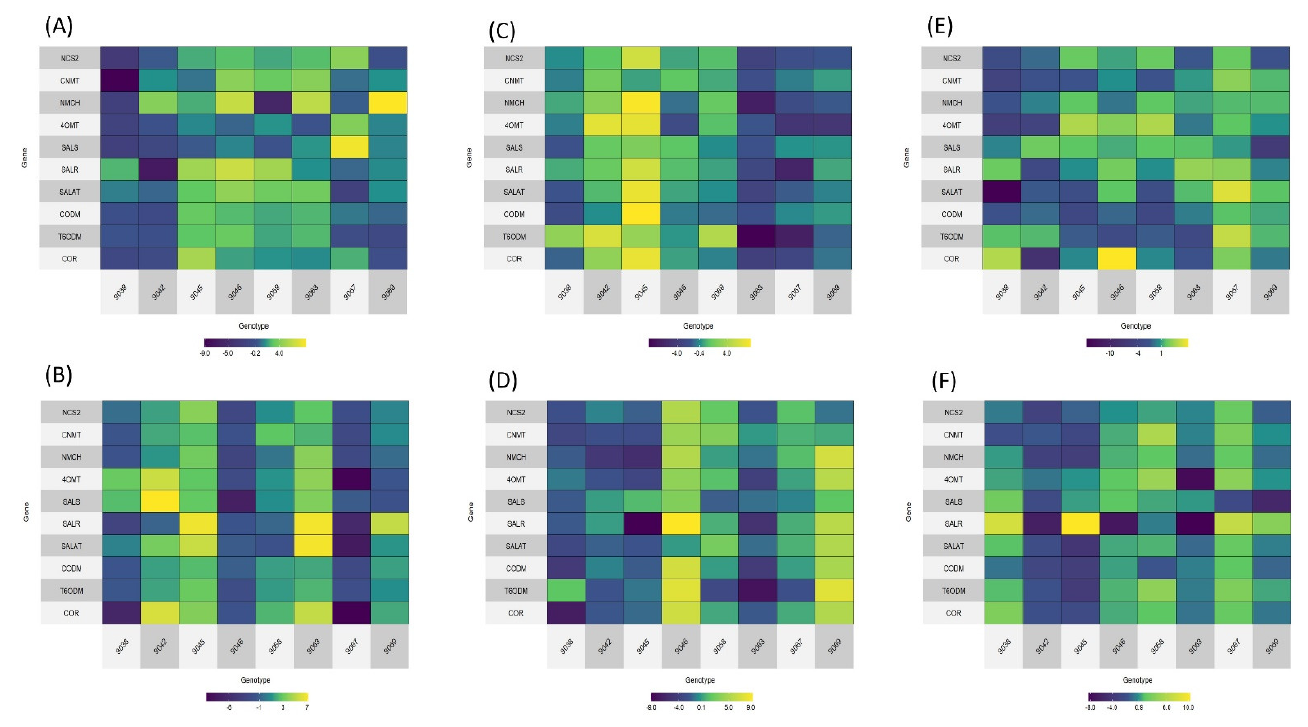
Figure 2. Heatmaps with gene expression profiles of mutant genotypes. Genes are sorted by their order in the morphine biosynthesis pathway. Blue color shows downregulation and yellow upregulation in comparison with the original variety. ( A ) Budding stage, epidermis. ( B ) Budding stage, slice. ( C ) Flowering stage, epidermis. ( D ) Flowering stage, slice. ( E ) Capsule stage, epidermis. ( F ) Capsule stage, slice.